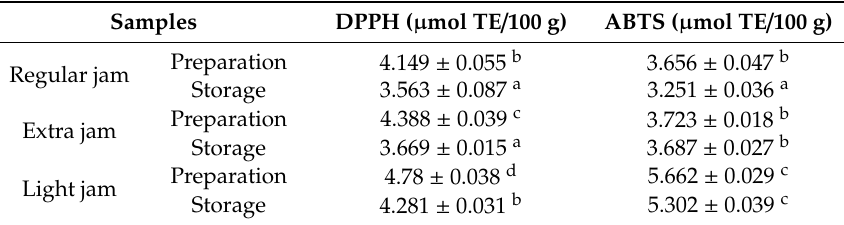
Table 4. Antioxidant activity of jam, extra jam and light tart cherry jams after preparation and after storage at room temperature for eight months.